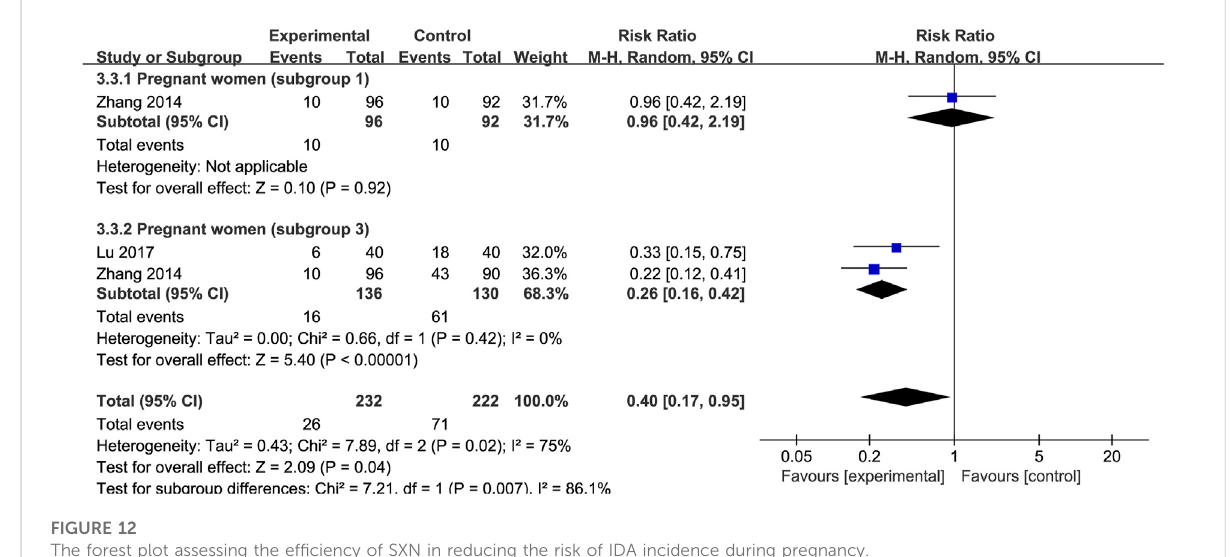
FIGURE 12 The forest plot assessing the ef fi ciency of SXN in reducing the risk of IDA incidence during